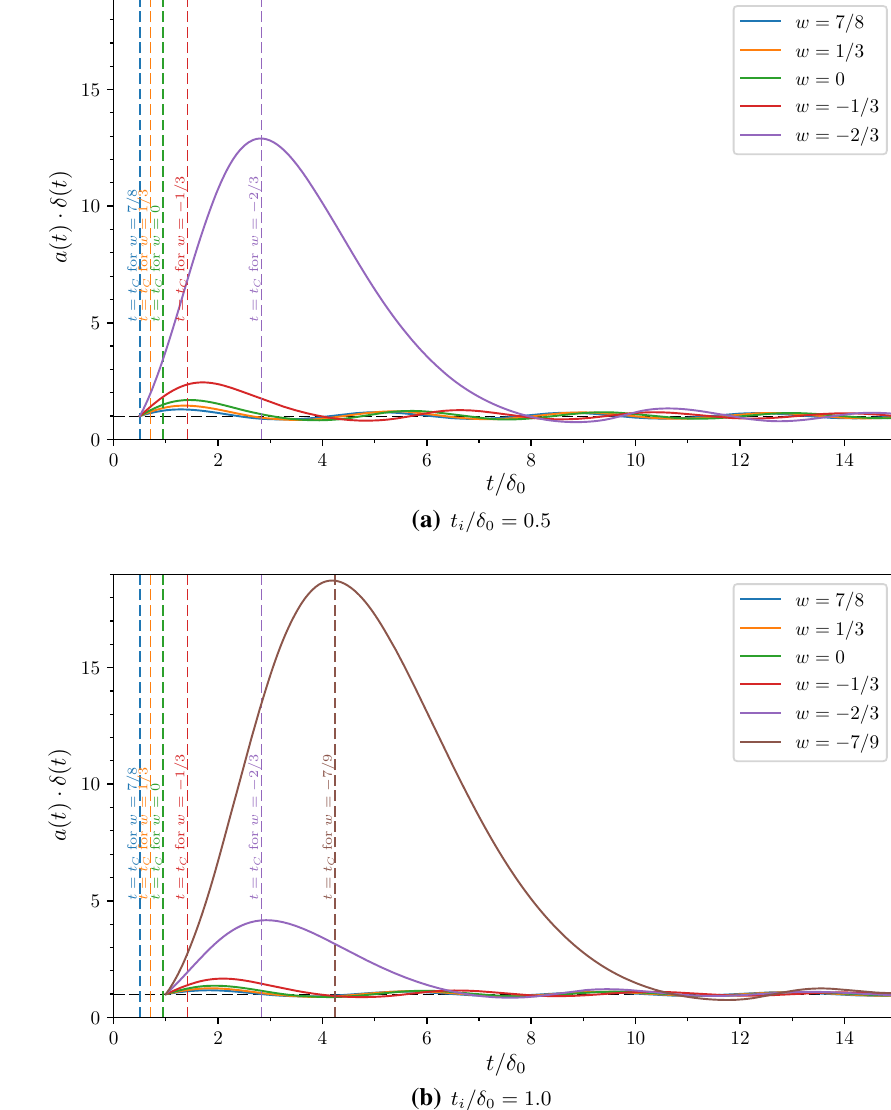
Fig. 8 Time dependence of the physical thickness of the wall, a ( t )δ( t ) , for different values of parameter w . Dashed horizontal line corresponds to δ 0 . Vertical dashed lines correspond to the moment t C at which C ( t C ) = 2 (the correspondence between color and w is the